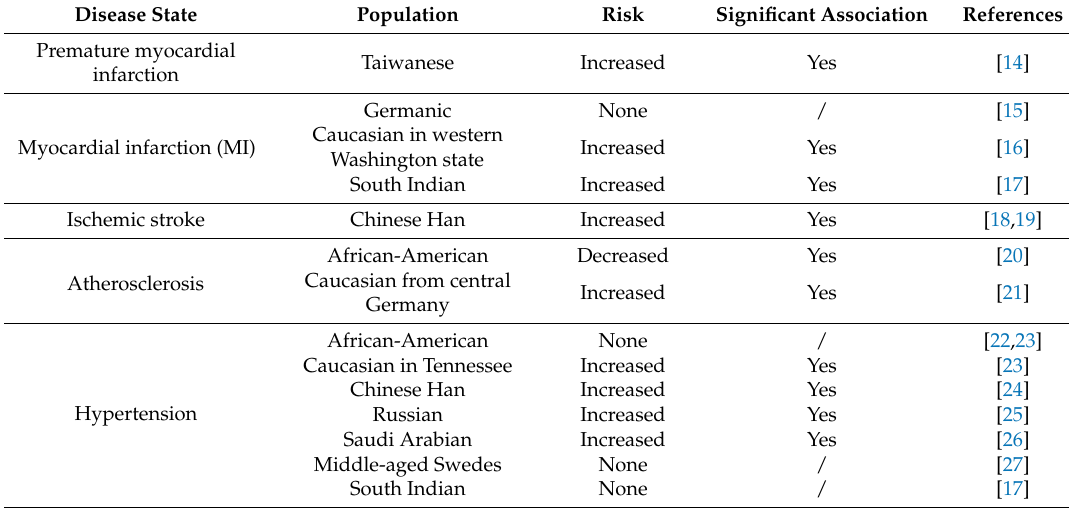
Table 1. Summary of the effect of CYP2J2*7 in altering the risk associated with developing cardiovascular dysfunction in different ethnic